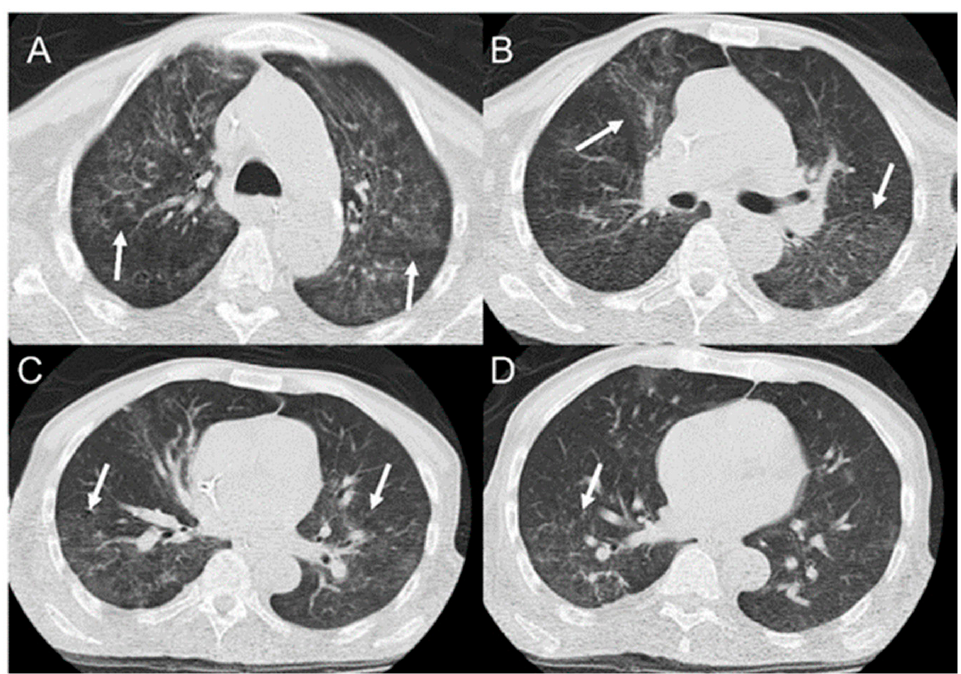
Figure 4. Computed tomography showing ground-glass opacities (arrows) with bilateral and sym- metric distribution, occurring mainly in the periphery and the middle-third of the lungs (“butterfly wing” pattern), as shown from top to bottom in ( A – D ).